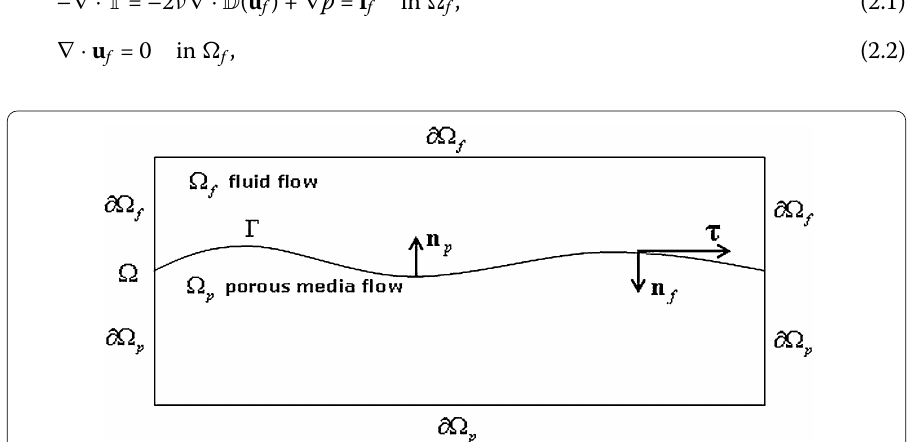
Figure 1 Global domain (cid:2) consisting of the fluid region (cid:2) f and the porous media region (cid:2) p separated by the interface